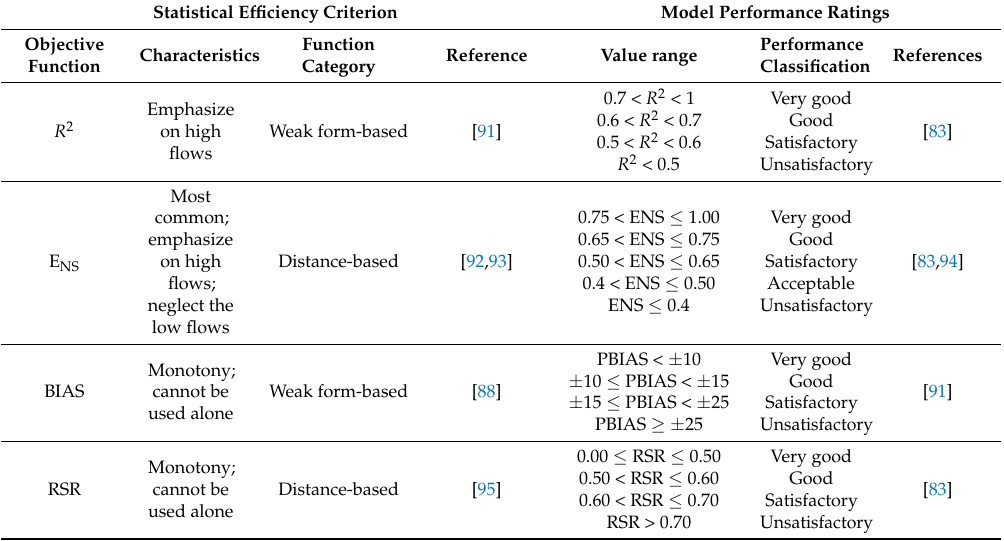
Table 2. Classical objective functions and model performance ratings for simulations of flow and sediment